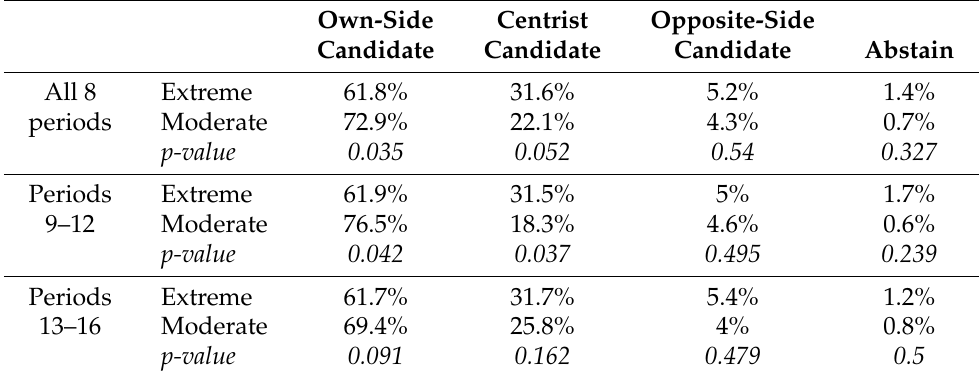
Table 4. Voting decisions of the leftists and